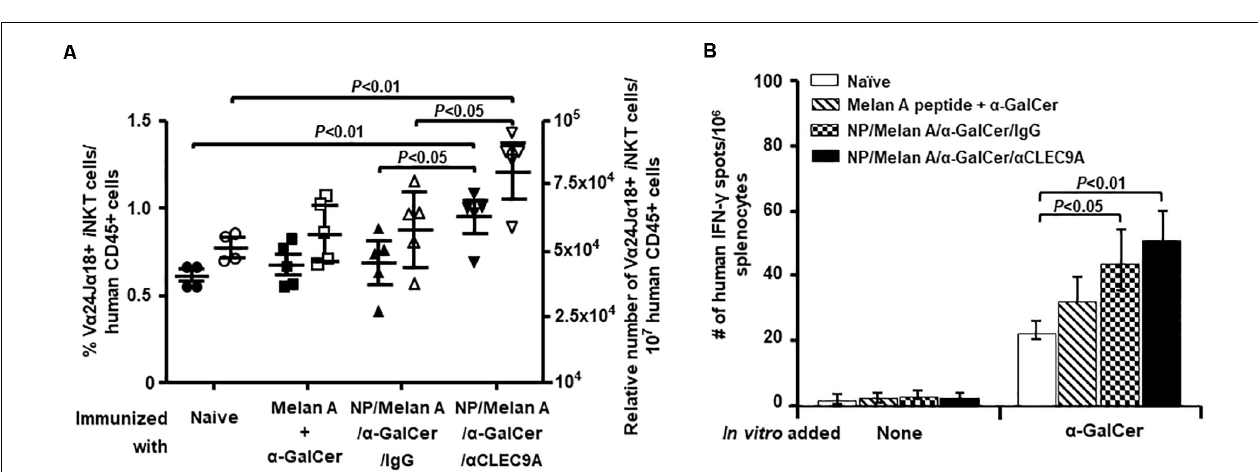
FIGURE 3 | Level of α -GalCer-reactive human i NKT-cell response induced by NP vaccines. (A) The percentage (closed symbols) and number (open symbols) of V α 24 + J α 18 + human i NKT cells among mouse CD45 + cells within splenocytes isolated from immunized HIS-CD8/NKT mice were determined by flow cytometry. (B) The relative number of α -GalCer-activated human i NKT cells that secrete IFN- γ among splenocytes from HIS-CD8/NKT mice immunized with NP-Melan-A vaccine was determined by an ELISpot assay. Results are displayed as the mean value and standard error ( n = 5). Statistical analyses were performed using ANOVA followed by Dunnett’s test and differences were considered if P <